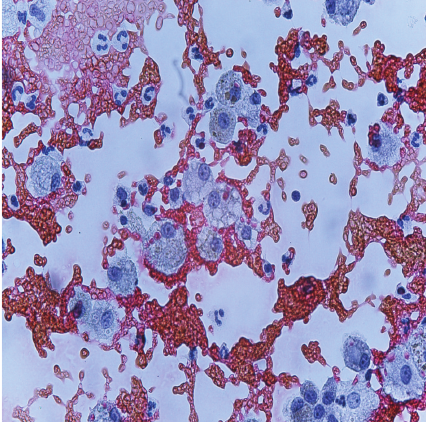
Figure 3: BAL specimen showing hemosiderin-laden macrophages. Staining for iron (Perls’ Prussian blue). Magnification ×